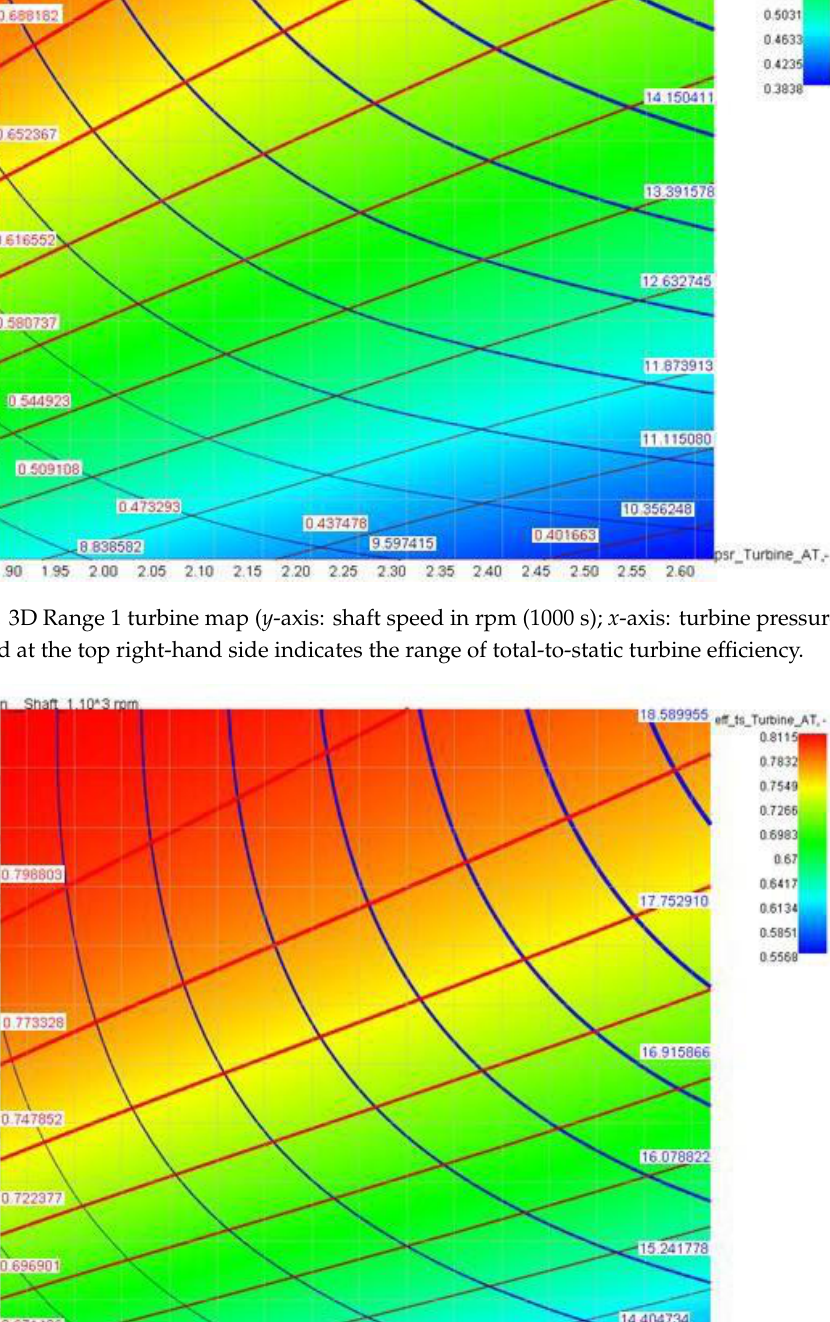
Figure 18. Prismatic Range 2 turbine map ( y -axis: shaft speed in rpm (1000 s); x -axis: turbine pressure ratio). The legend at the top right-hand side indicates the range of total-to-static turbine efficiency.